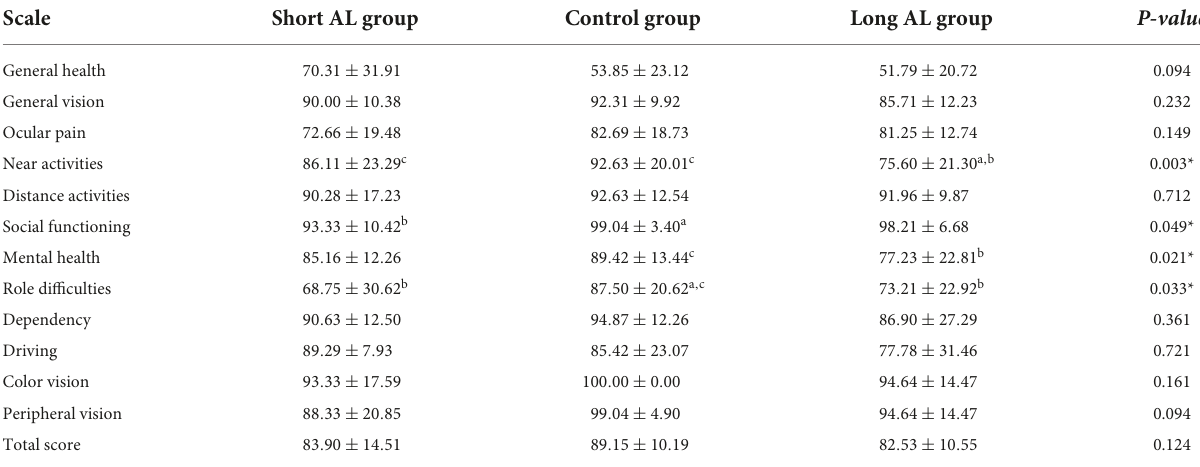
TABLE 5 General life quality with NEI